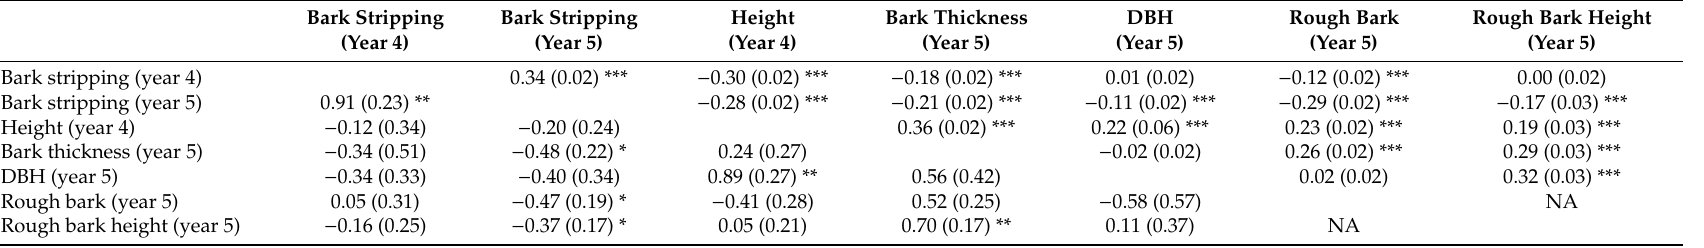
Table 7. Phenotypic (above diagonal) and genetic Type A (below) correlations of the traits that were assessed in the Payanna trial with the standard errors given in parentheses. The significance of the di ff erence of the correlations from zero are indicated: *** = p < 0.001, ** = p < 0.01, * = p < 0.05. NA = not applicable as only assessed on subset of individuals which had developed rough